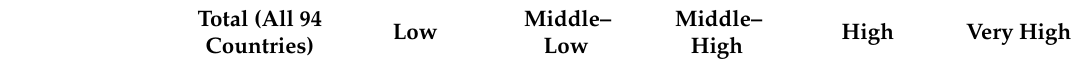
Table 7. Estimation results of dynamic panel models with a fixed effects estimator and robust Driscoll–Kraay standard errors (one-way CFEM and two-way